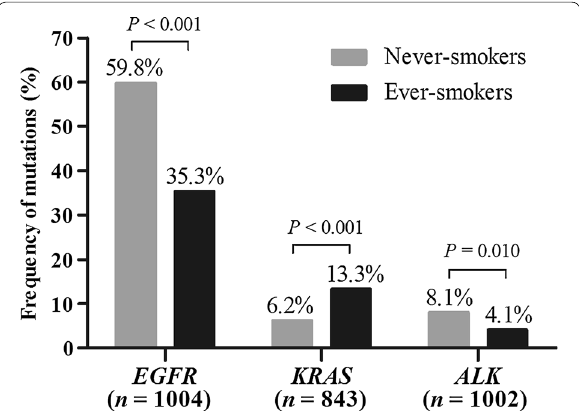
Fig. 1 Frequencies of driver mutations in 1153 patients with lung adenocarcinoma according to smoking status. EGFR epidermal growth factor receptor, KRAS Kirsten rat sarcoma viral oncogene homolog, ALK anaplastic lymphoma kinase. n is the number of patients with lung adenocarcinoma who were tested for each muta‑